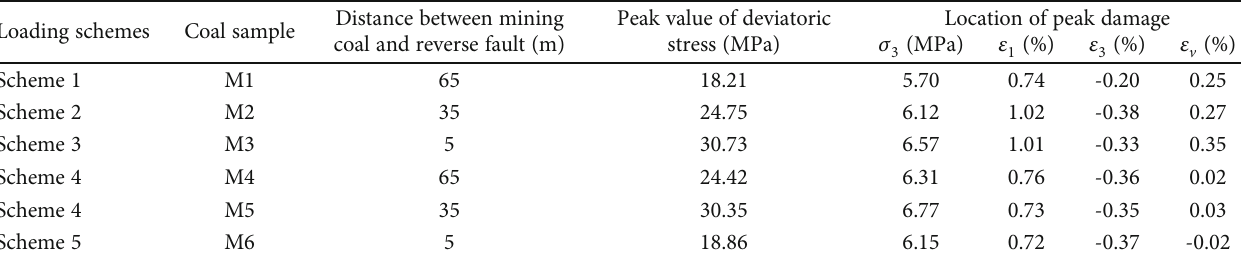
Table 2: Physical parameters of the